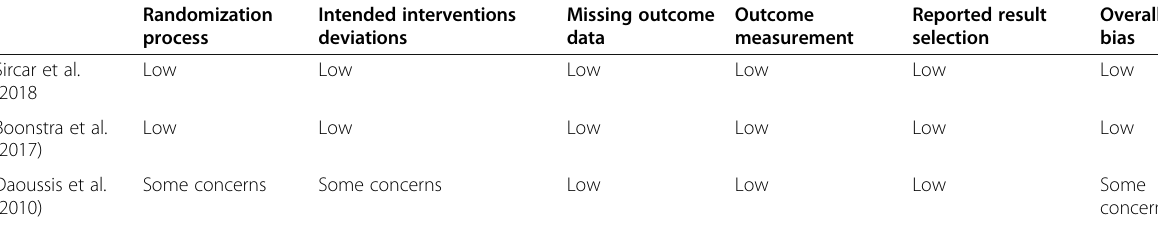
Table 3 Risk of bias in RCTs (Rob